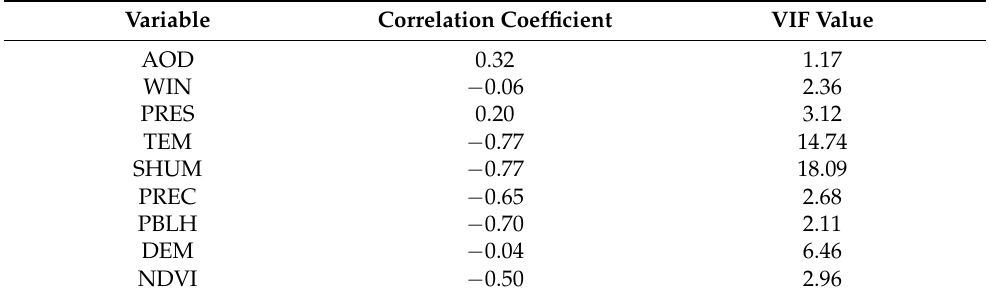
Table 2. Correlation coefficient and collinearity test between each variable and PM 2.5 concentration.